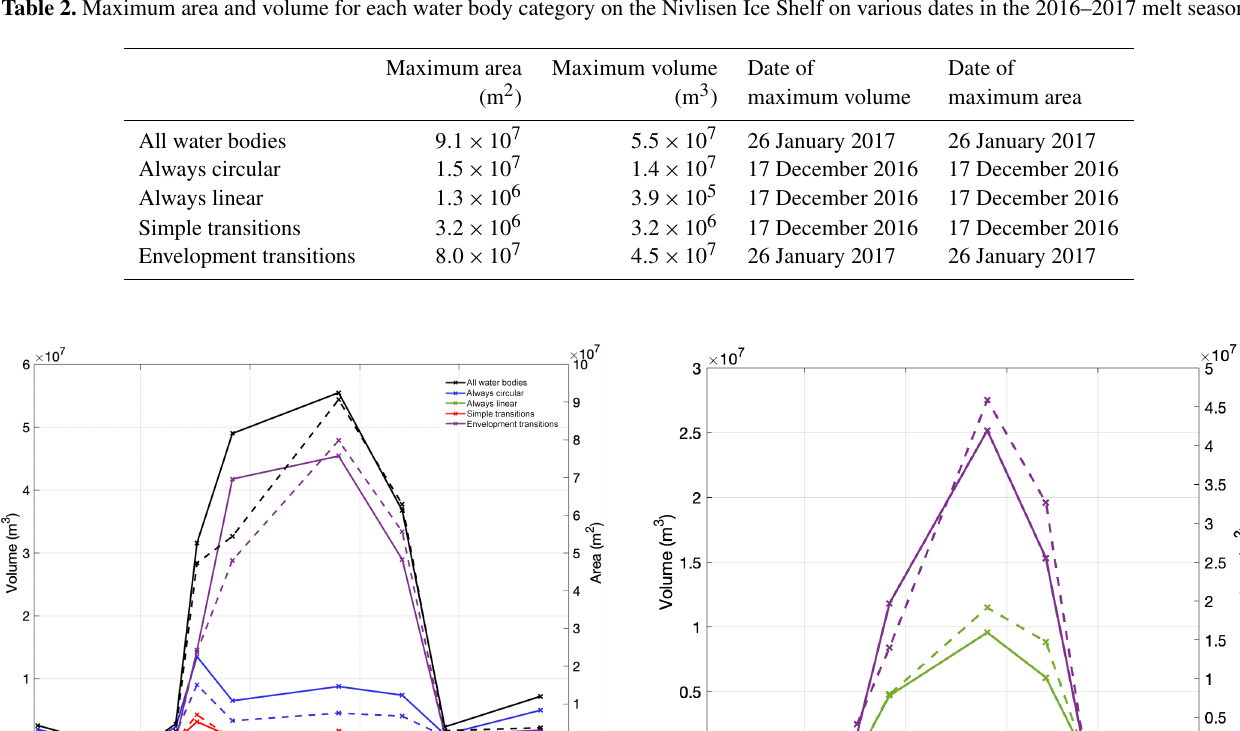
Table 2. Maximum area and volume for each water body category on the Nivlisen Ice Shelf on various dates in the 2016–2017 melt season.